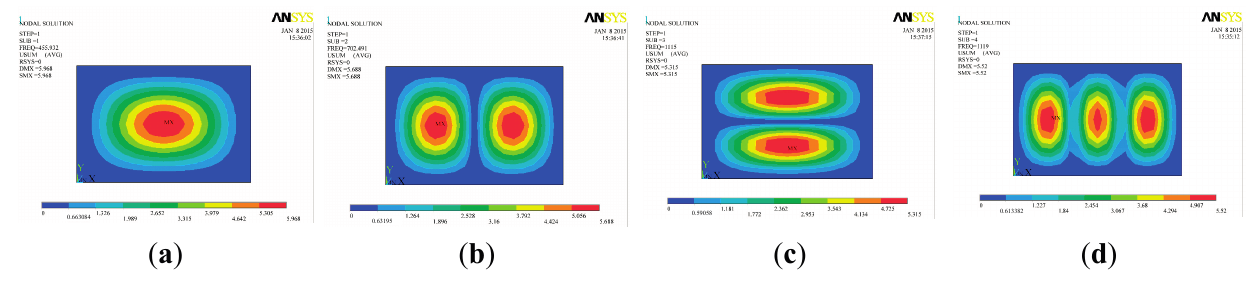
Figure 11. The first 4 order modal shape contour of sensitive plate ( a ) modal 1; ( b ) modal 2; ( c ) modal 3; ( d ) modal